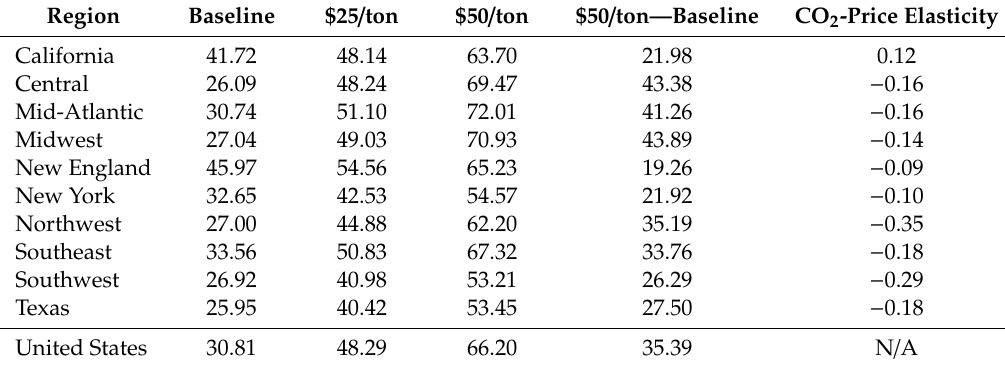
Table 5. Average annual prices ($ / MWh) by region for the three scenarios. The fifth column displays the price di ff erence between the $50 / ton and baseline scenarios. The last column displays emissions elasticity of price, calculated as percent change in total emissions divided by percent change in average price. The last row displays the national average weighted by regional